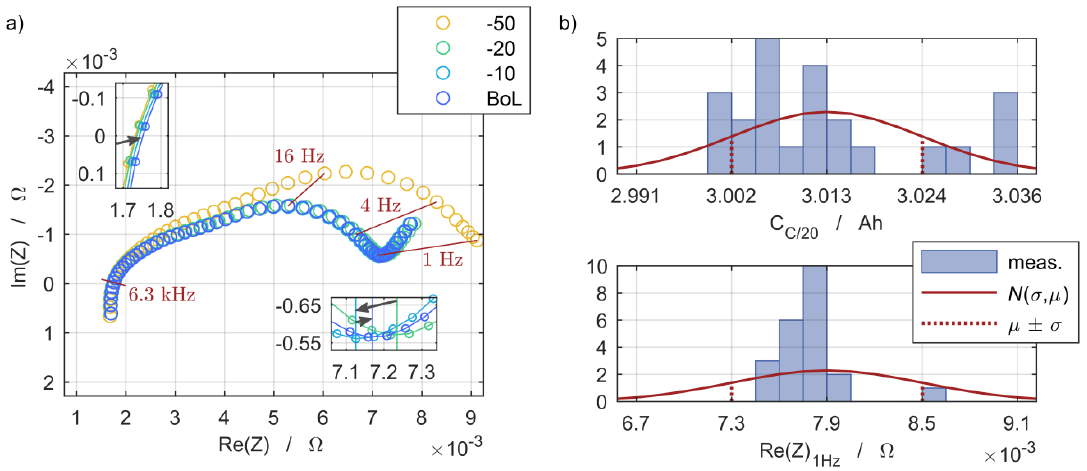
Figure 5. ( a ) Transition of the polarization effects and ohmic resistance during preliminary characterizations based on electrochemical impedance spectra prior to the definition of the begin of life (BoL) state. ( b ) Begin of life state deviation and normal distribution N ( σ , µ ) of the C/20 cell discharge capacity and real part of the electrochemical impedance evaluated at 1 Hz to briefly compare the polarization